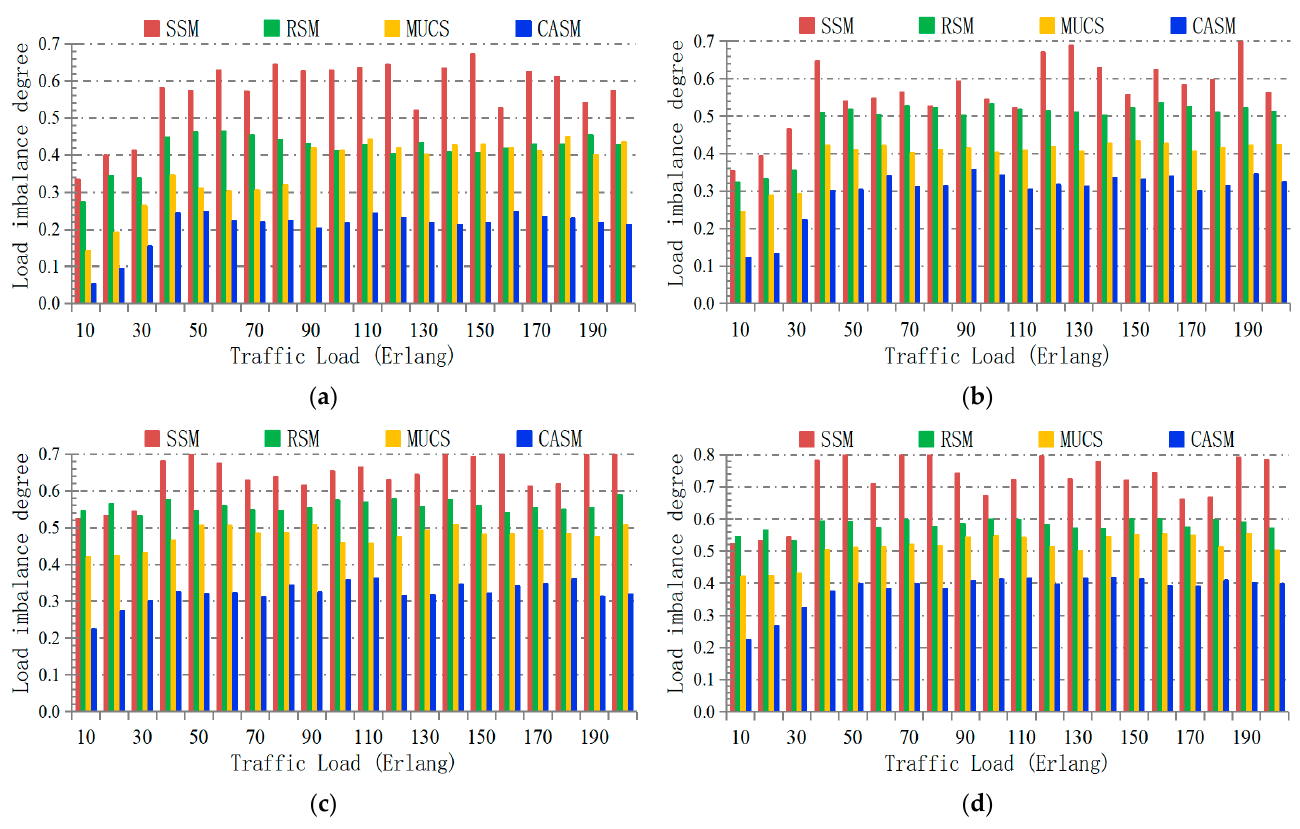
Figure 4. Load imbalance degree of different schemes under different topologies: ( a ) NSFNET Topology; ( b ) OS3E Topology; ( c ) Ta2 Topology; ( d ) Interoute Topology.